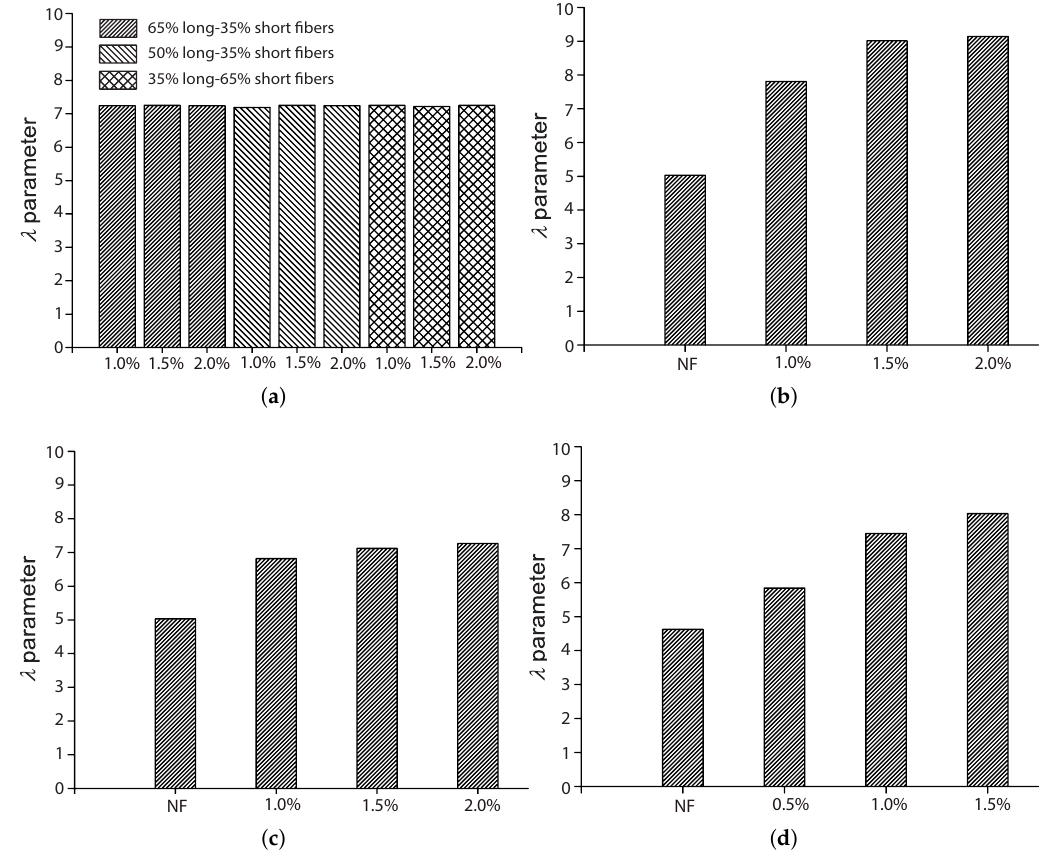
Figure 11. Influence of fiber volume fraction on the scale parameter, λ : ( a ) Singh et al. [42]; ( b ) Mohammadi and Kaushik [17], 50 mm fiber length; ( c ) Mohammadi and Kaushik [17], 25 mm fiber length; ( d ) Goel and Singh